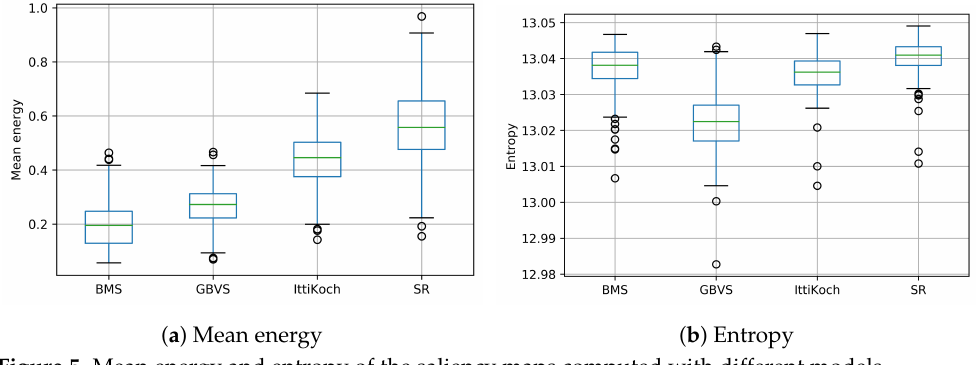
Figure 5. Mean energy and entropy of the saliency maps computed with different models. Table 1. Tukey multiple comparisons of means for energy. 95% family-wise confidence